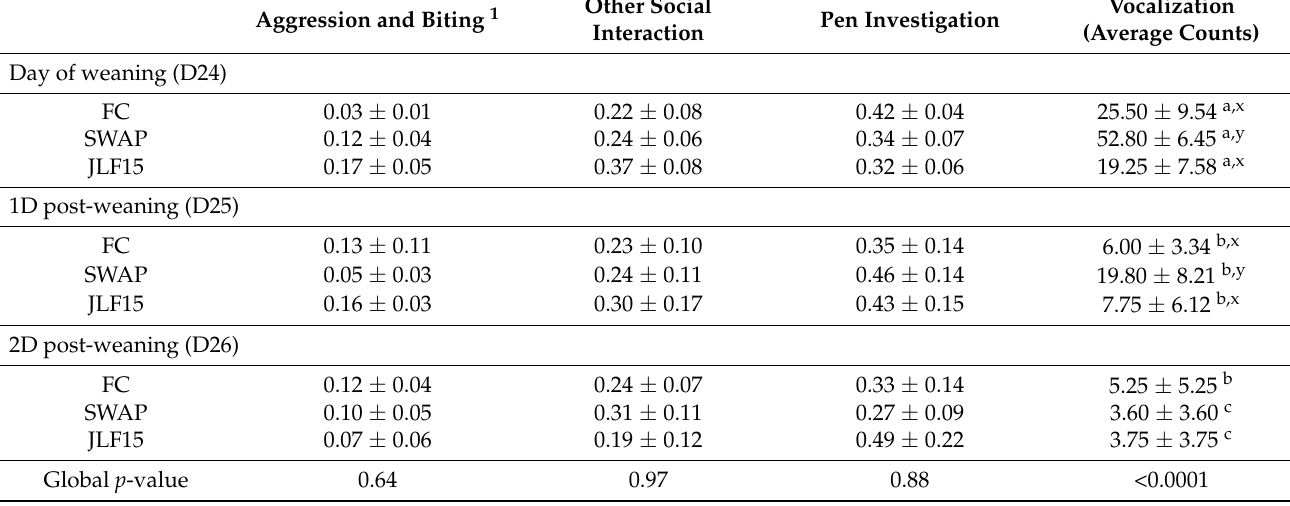
Table 7. Proportion (number of behavior/total active behaviors) of active behaviors in sows (mean ± SE) in the post-weaning period in three farrowing systems (FC, n = 4: conventional farrow- ing crate; SWAP, n = 5, and JLF15, n = 4: farrowing pens with temporary crating). Values with a different superscript ( a , b , c ) correspond to a significant difference ( p < 0.05) between sampling days in the same farrowing system. Values with a different superscript ( x , y ) correspond to a significant difference ( p ≤ 0.05) between farrowing systems on the same sampling day. n indicates the number of